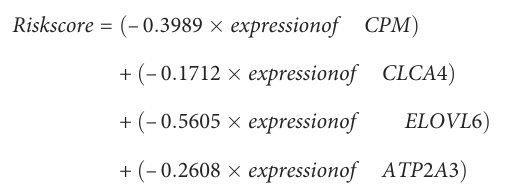
(Supplementary Table 4) The risk scores of all patients in the TCGA training cohort were calculated, and then the patients